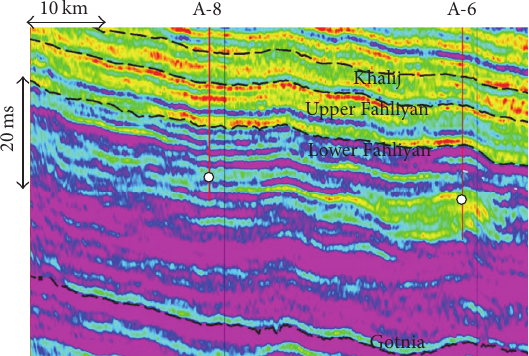
Figure 11: The inverted seismic section showing the clinoform sedimentary feature, forming a local vertical closure, hence, controls oil/water contact (OWC) in well A-6. The white circles indicate the OWC in wells A-8 and